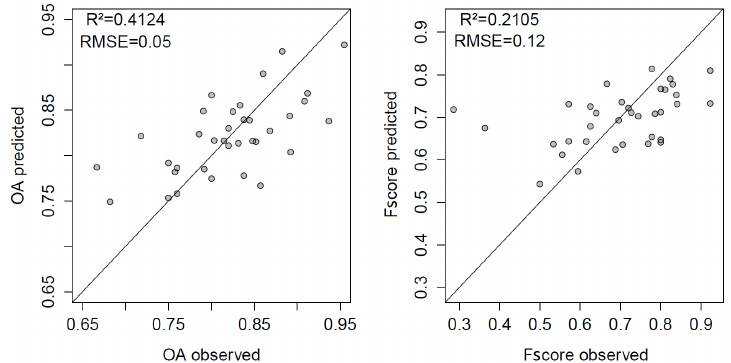
Figure 15. OA and F-score predicted by the multiple regression compared to the OA and F-score observed.